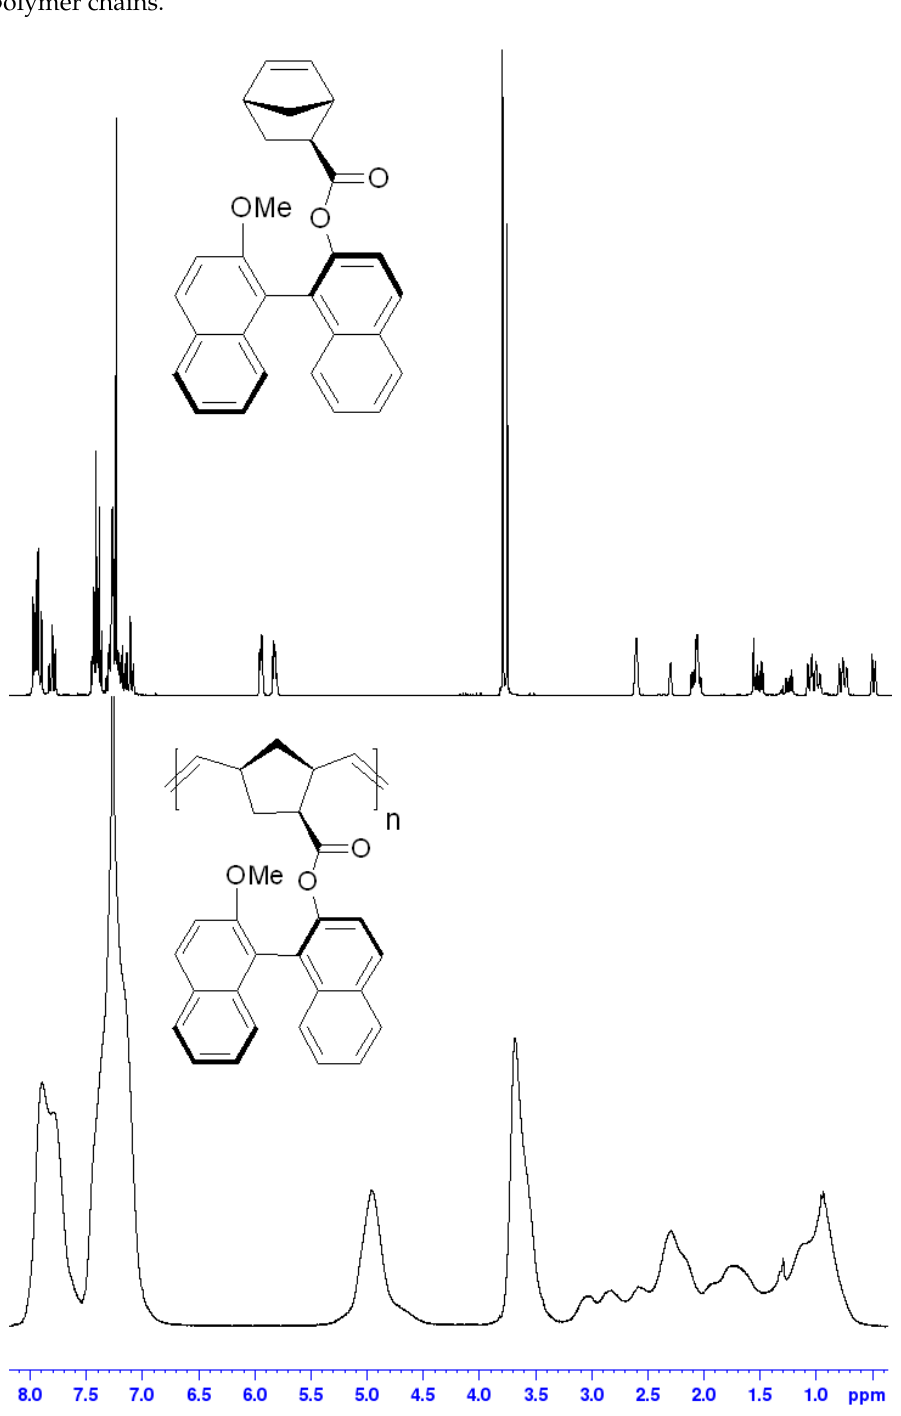
Figure 2. 1 H NMR spectra of the monomer and metathesis polymer based on the ester of exo -5- norbornenecarboxylic acid and 1,1 ′ -bi-2-naphthol (CDCl 3 ).